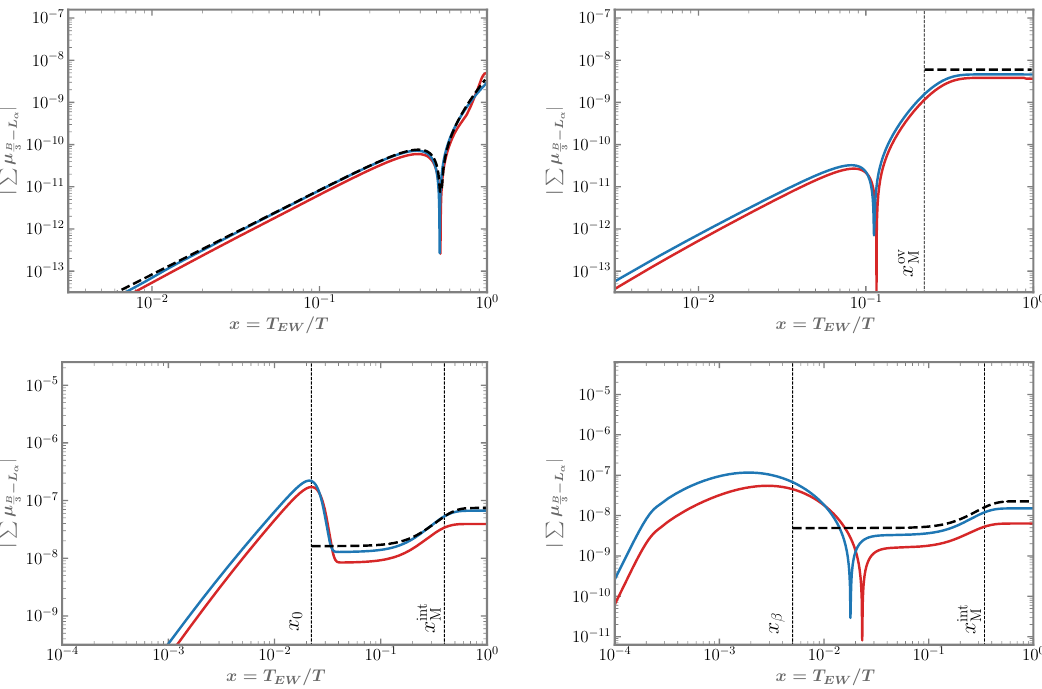
Figure 7 . Comparison of the asymptotic analytical result (black dashed) to i) the numerical result with the same settings (blue) and ii) the full non-linear numerical solution (red) in the four scenarios (a)-(d) as described in the main text. In the top left we show the scenario (a), in the top right the scenario (b), in the bottom left the scenario (c) and in the bottom right the scenario (d). The vertical dashed lines indicate projection times used for the analytical